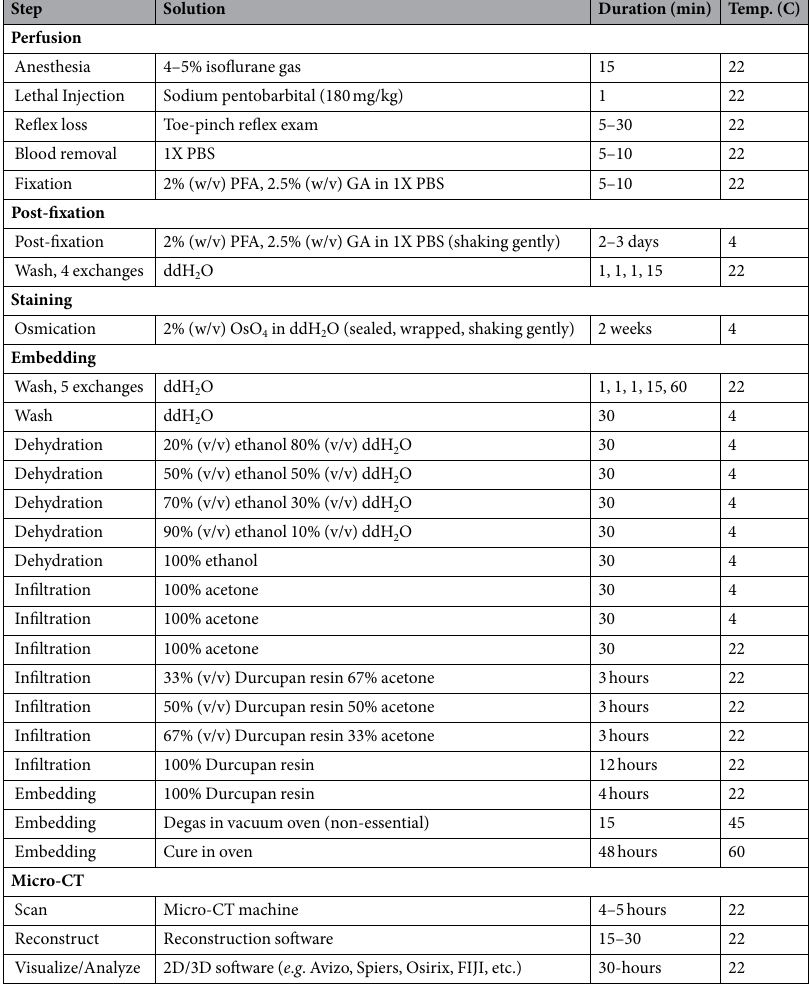
Table 1. Detailed Protocol for Small Whole-Brain Preparation for Micro-CT